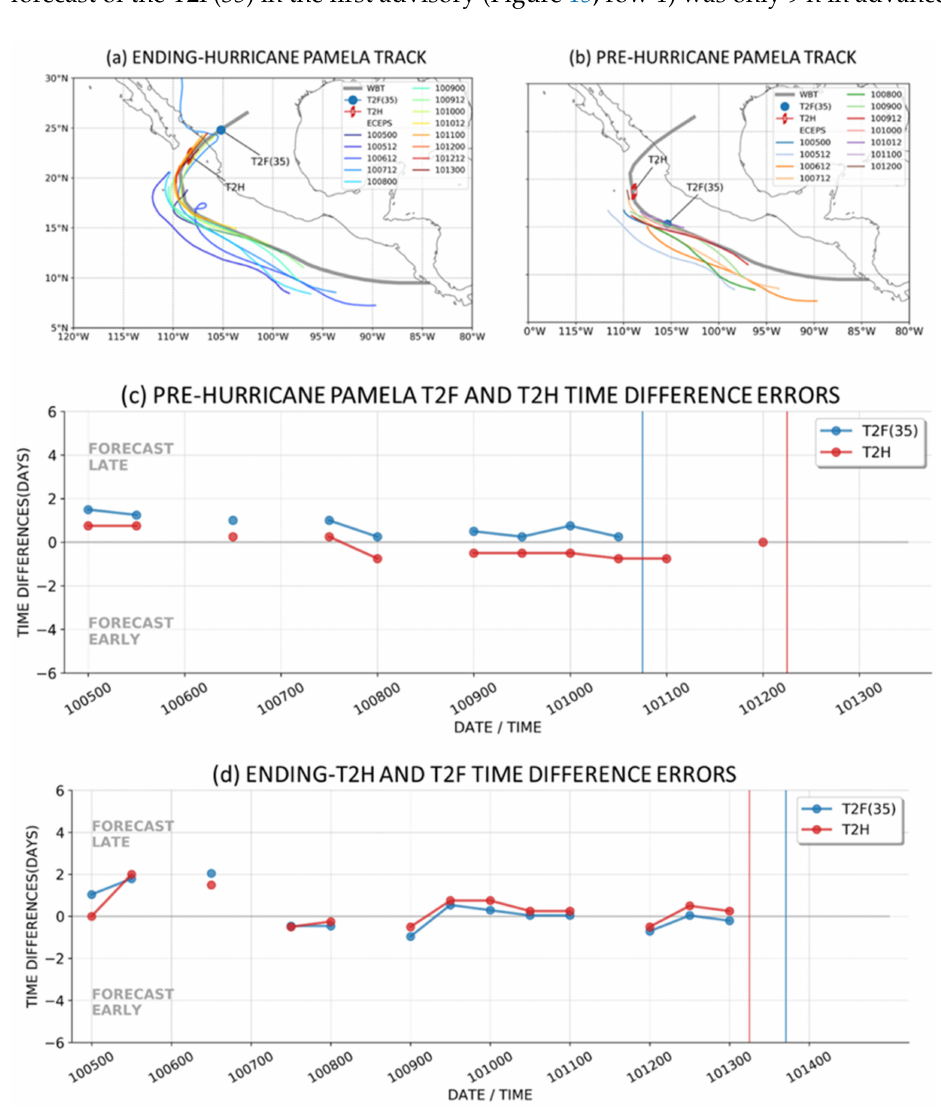
Figure 15. Summary of the ECEPS pre-formation and ending-storm predictions as in Figure 3 except here for the Hurricane Pamela